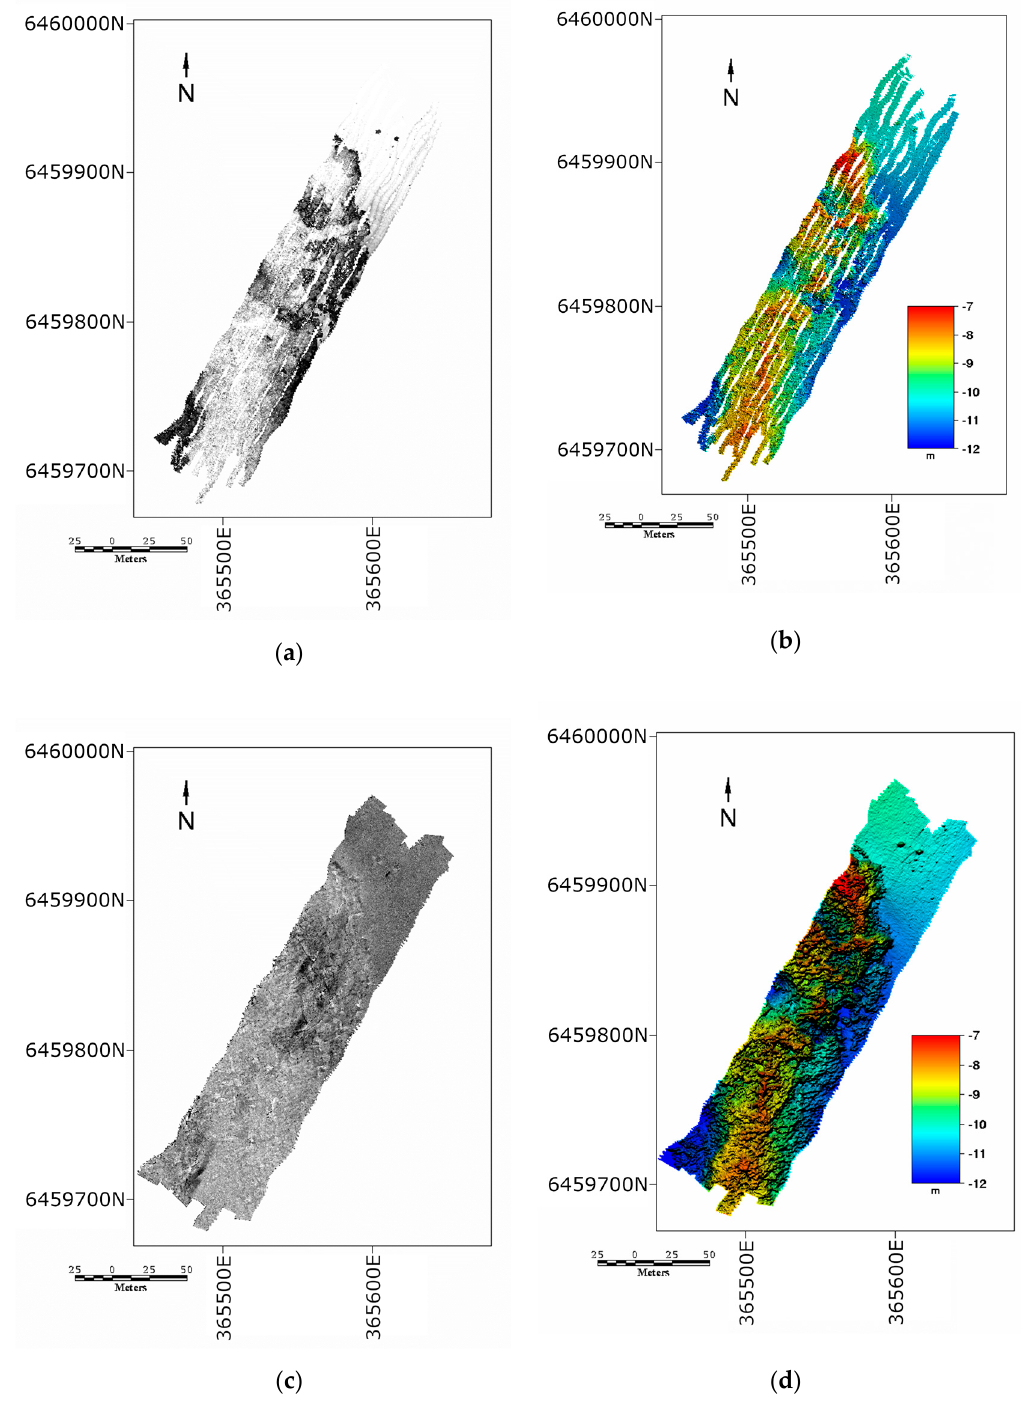
Figure 4. ( a ) Light Detection and Ranging (LiDAR) intensity, ( b ) LiDAR bathymetry, ( c ) multibeam backscatter, and ( d ) multibeam bathymetry. Note that the LiDAR intensity and multibeam echosounder (MBES) are relative values so unscaled. All images are in SUTM50 projection.